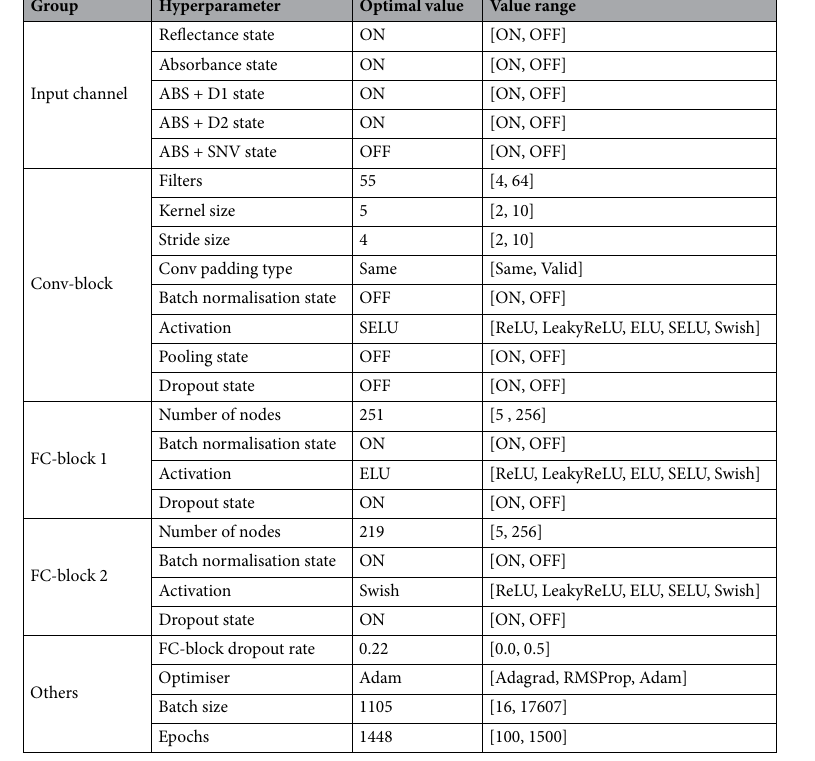
Table 1. Optimal 1D-CNN hyperparameters.